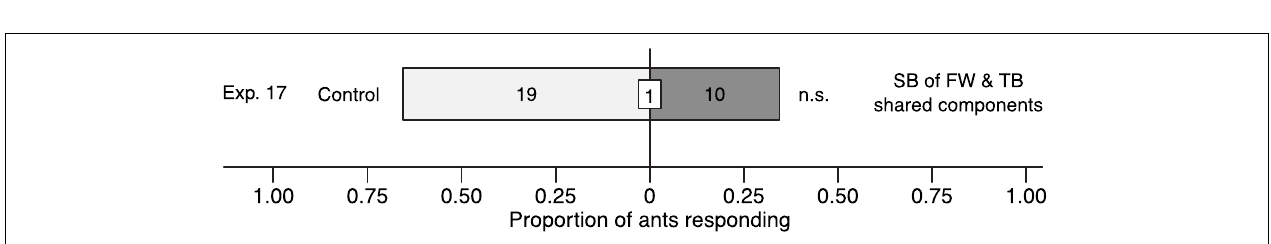
FIGURE 7 | Effect of a synthetic blend (SB) comprising the two floral odorants [( E )- β -caryophyllene, α -humulene] shared between fireweed (FW) and thimbleberry (TB) on responses of C. modoc worker ants in Y-tube olfactometer ( Figure 1 ) experiment 17. The SB was formulated in pentane/ether (1/1) and tested at a dose 10-fold higher (10 × ) than volatiles released from thimbleberry (Exp. 4). The same volume of pentane/ether (1/1) served as the control stimulus. Numbers within bars indicate the number of ants responding to test stimuli and the number within the white inset box indicates a single non-responding ant; n.s., not significant; p > 0.05.